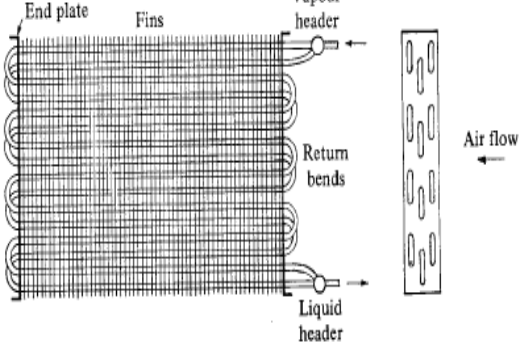
Fig.7: Element of condenser